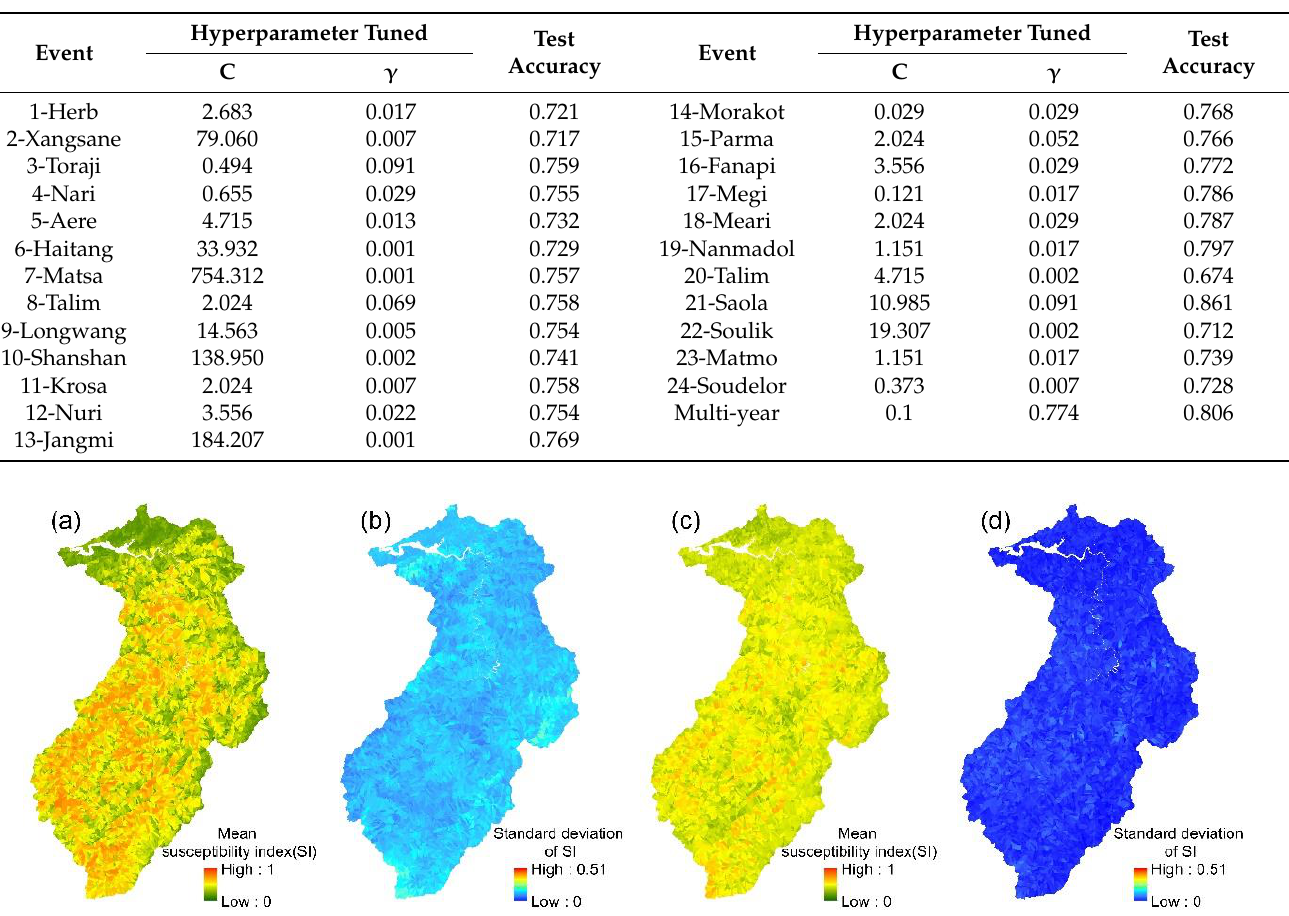
Table 6. The tuned hyperparameters and model performances for SVM models.